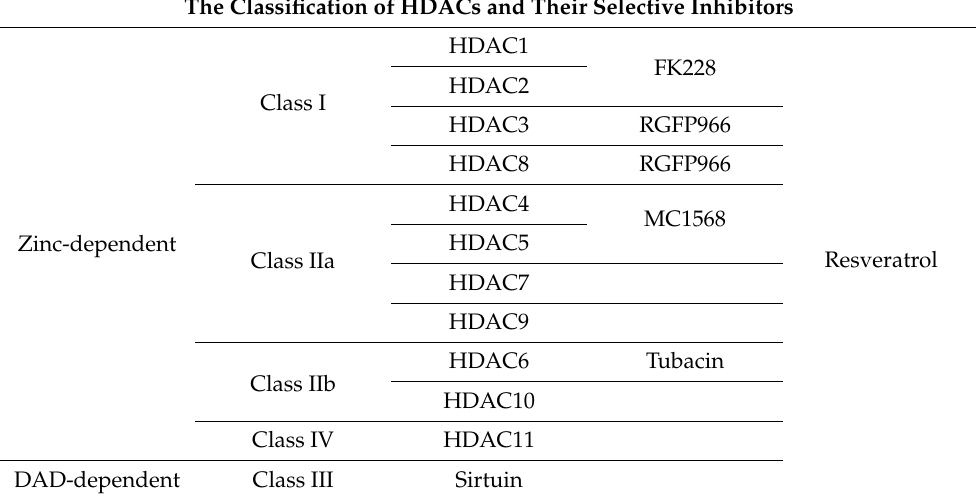
Table 1. The 18 types of HDAC and 6 selective HDAC